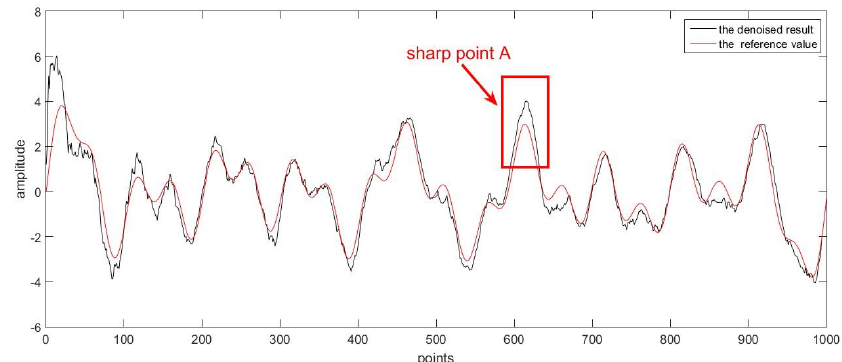
Figure 9. The denoised result and the reference value.